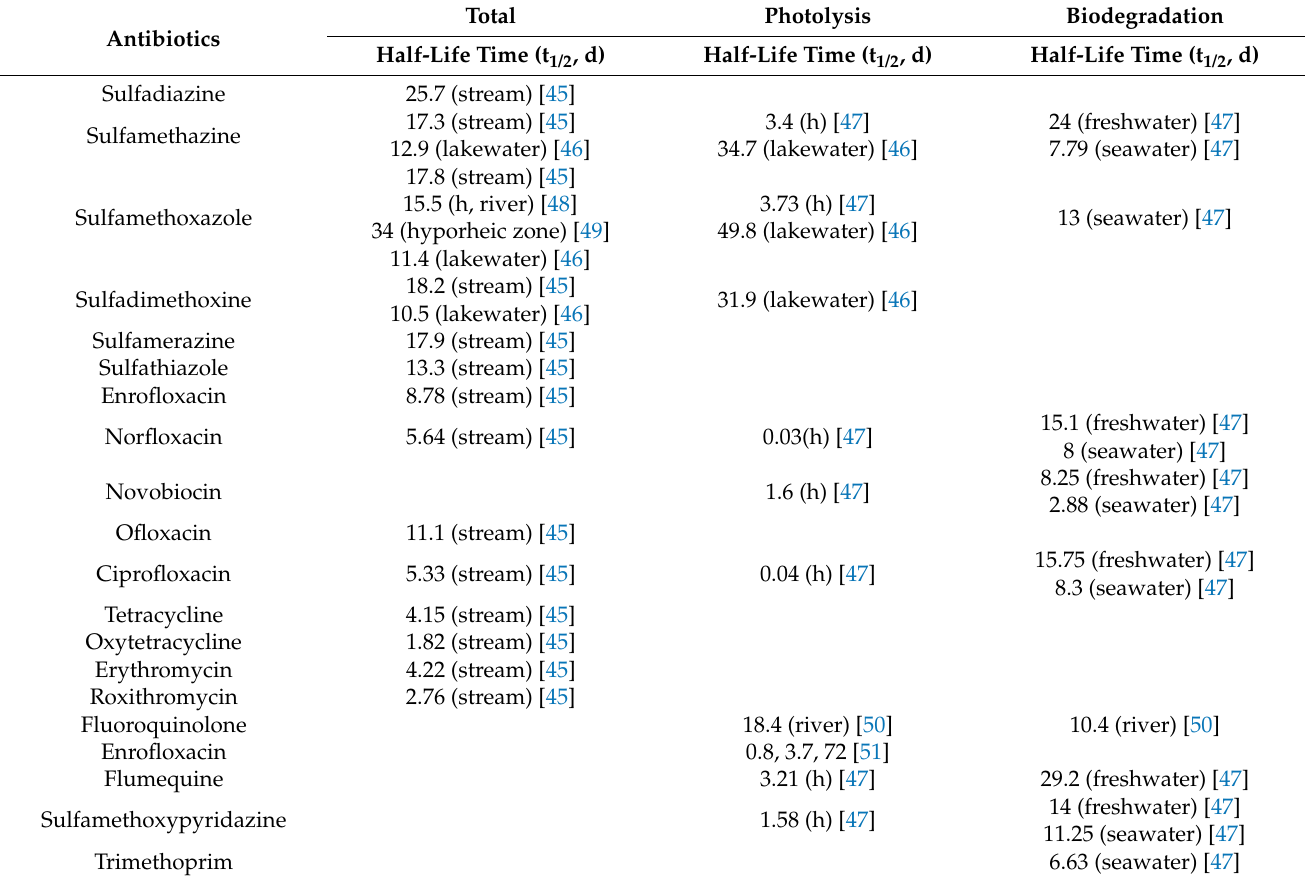
Table 2. The half-life times of antibiotics reported in different